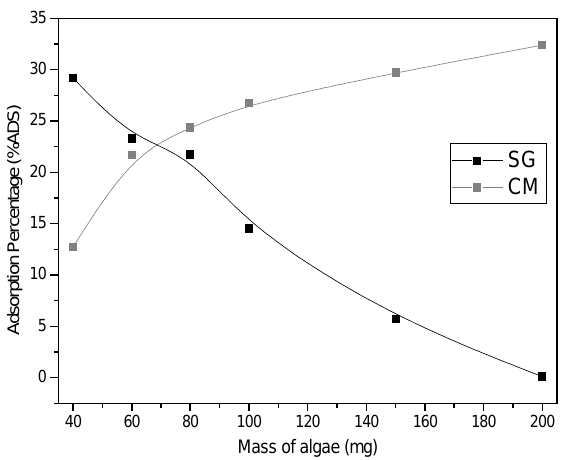
Figure 6. Effect of the adsorbent dose on the adsorption of phenol on marine algae. Initial solution pH: 10 and Phenol concentration: 100 mg/L.